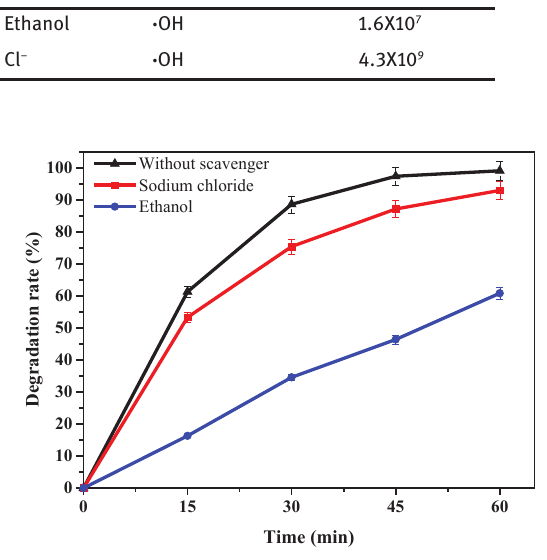
Table 4: Kinetic rate constant of some organic and inorganic scavenging compounds with · OH. Figure 10: A schematic mechanism for the nanocatalysis of MO dye over Fe-doped TiO (e - : negative electron, h + : positive hole, MO: Methyl Orange)